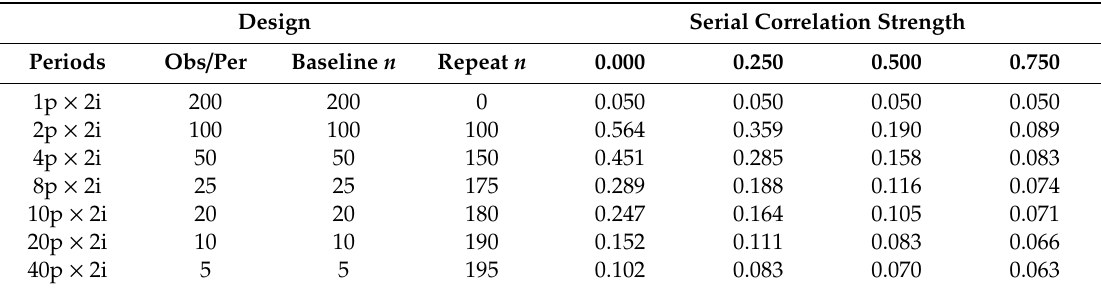
Table 4. The effect of serial correlation and intervention period stacking on the power to detect a carryover effect of 0.30 standard deviation units in an N-of-1 crossover trail with 400 total observations based on the proposed analytical model. A type I error rate of 0.05 was assumed.